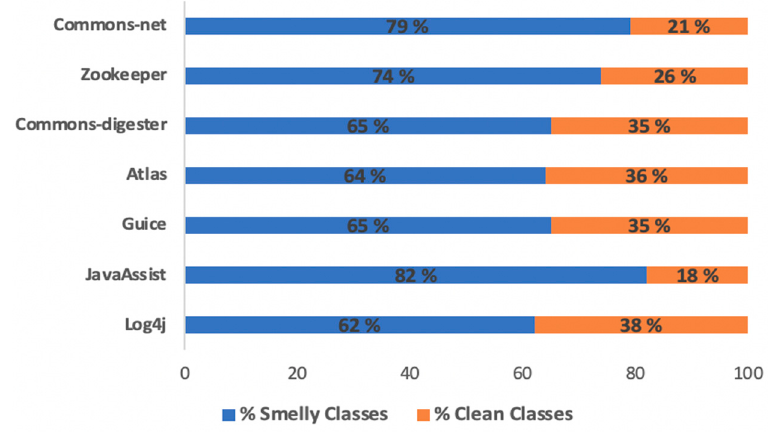
Figure 2. Percentage of smelly and clean files.